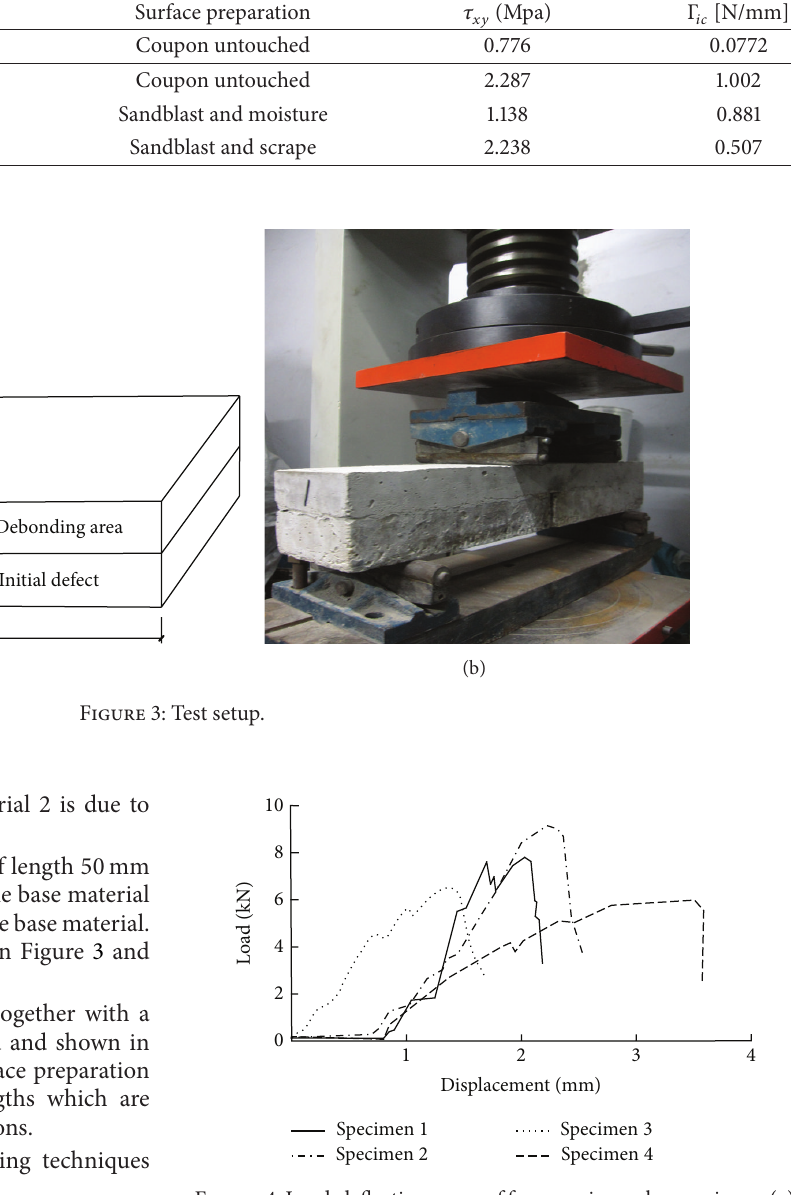
Figure 4: Load-deflection curve of four repair overlay specimen: (a) Specimen 1, (b) Specimen 2, (c) Specimen 3, and (d) Specimen